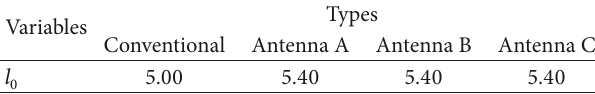
Table 2: Feeding position of different antennas (unit: mm).